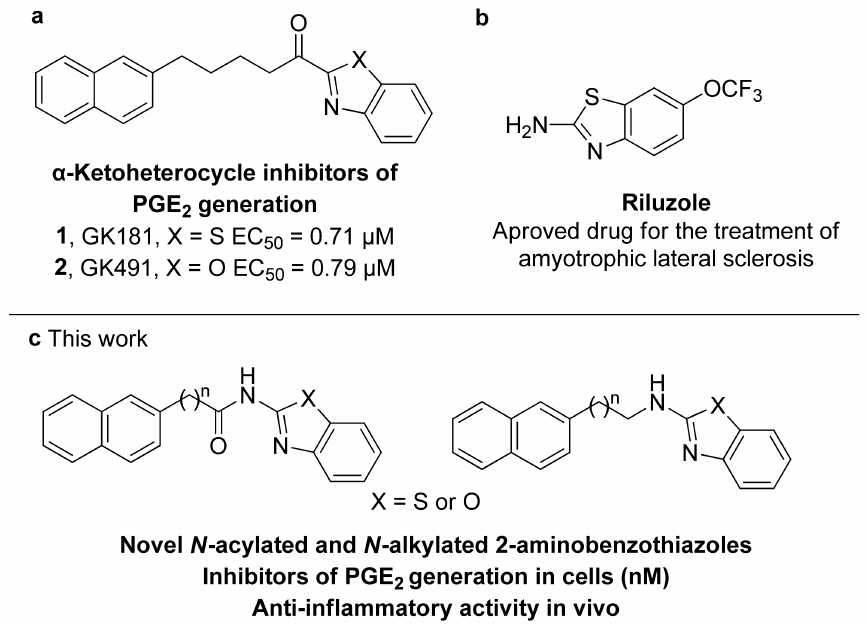
Figure 1. Bioactive 2-substituted benzothiazoles and benzoxazoles. ( a ) Previously developed α -ketoheterocycle inhibitors of PGE 2 generation; ( b ) riluzole; ( c ) N -acylated and N -alkylated 2- aminobenzothiazole and benzoxazole inhibitors of PGE 2 generation designed in the present